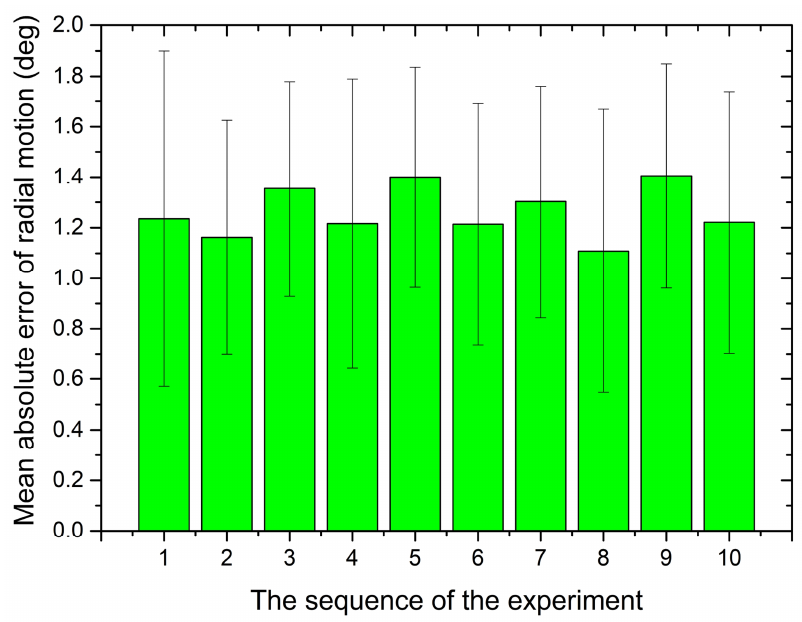
Figure 12. Mean error of ten times experiments for the radial motion.